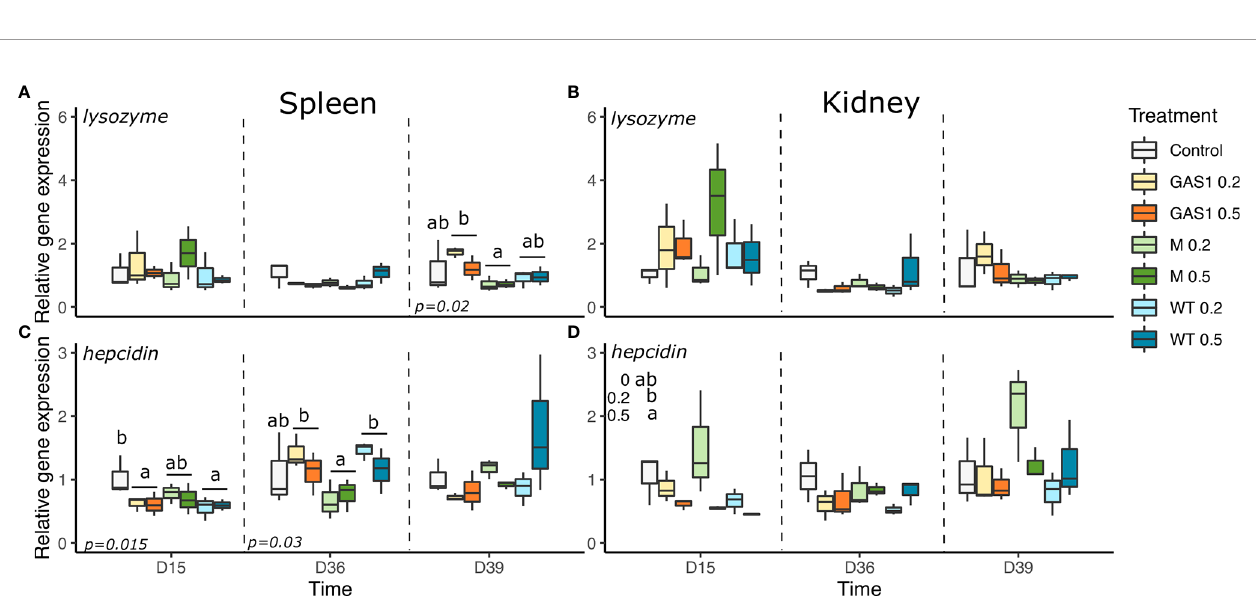
FIGURE 6 | Effects of dietary beta glucans on C-type lysozyme and Hepcidin genes expression in the spleen or kidney of fi sh sampled during the nutrient test on D15 and D36, or 2 days after the bacterial challenge (D39). (A) lysozyme gene expression in spleen. (B) lysozyme gene expression in kidney. (C) Hepcidin gene expression in spleen. (D) Hepcidin gene expression in kidney. Relative transcript (mRNA) levels were determined by real-time RT-PCR and normalized by the arithmetic mean of ef-1 a gene expressions. Values are expressed as mean ± SD of three pool samples per experimental condition (3 fi sh per pool sample). Statistical differences, highlighted by letters, are indicated for glucan concentrations in front of 0%, 0.2%, and 0.5% next to the corresponding plot, for glucan type by letter above the horizontal bar grouping the two doses of the same glucan, for glucan type × concentrations interactions above each box. P values are shown at the bottom of each graph at a given time point (D15, D36, or